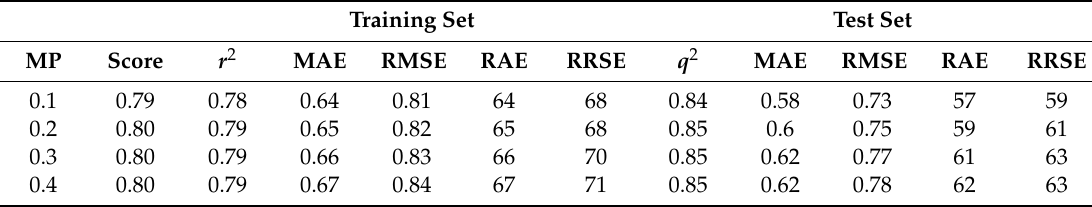
Table 2. Performance of the ANNs as a function of the momentum parameter. Training Set Test